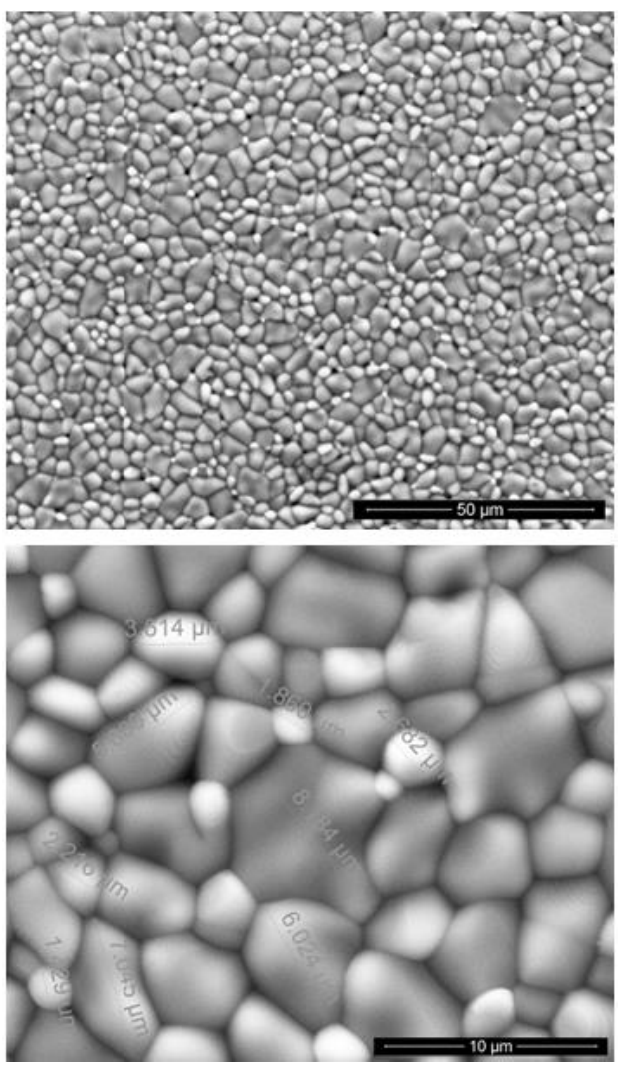
Figure 7. SEM microstructures of the sample surface after pressing with a force of 2 kN.